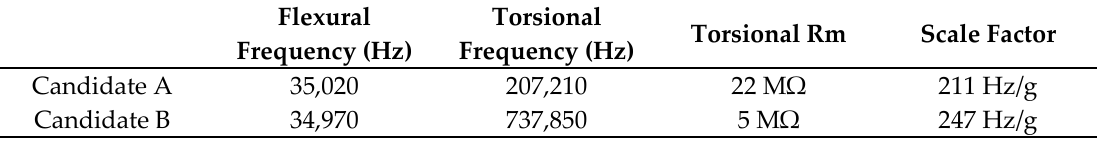
Figure 3. The new accelerometer design and an enlargement of the area with the vibrating beam with the torsional resonator at its centre on the right. Table 1. Characteristics of the two versions of accelerometers “Candidate A” and “Candidate B”.